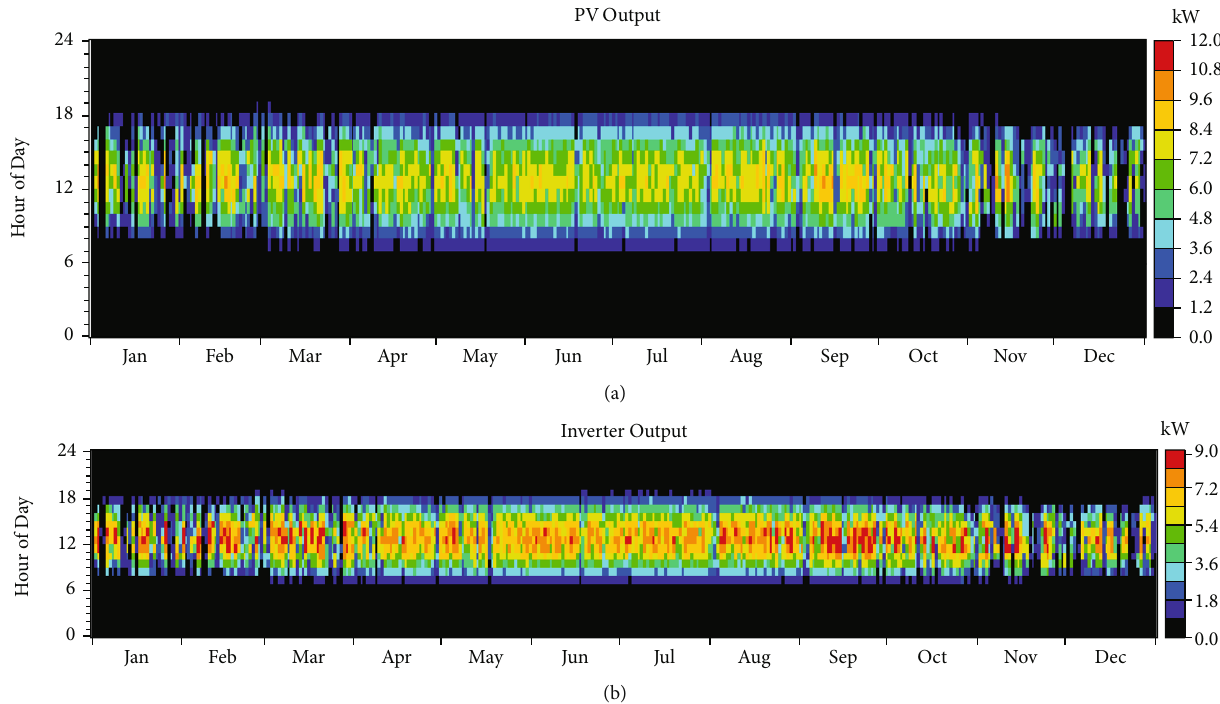
Figure 9: Performance contours of (a) PV output and (b) inverter output.